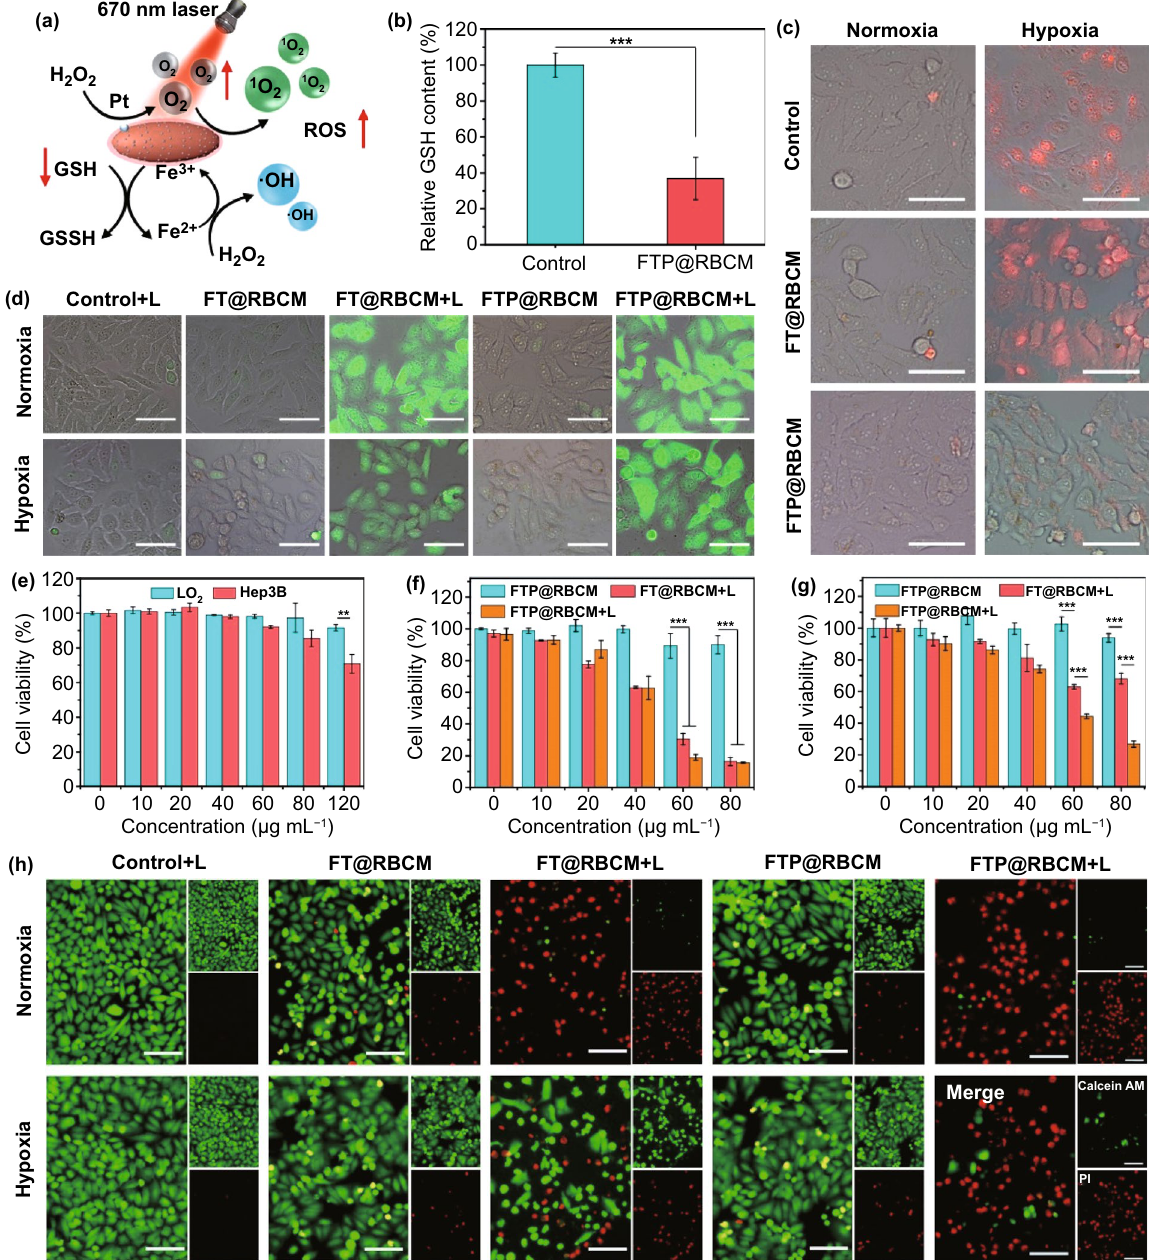
Fig. 3 a Schematic illustration of the multiple catalytic activities of FTP@RBCM. b Relative GSH content of Hep3B cells with various treatments ( n = 3). c Fluorescence microscopy images of probes [Ru(dpp) 3 ]Cl 2 to detect intracellular oxygen with various treatments. Scale bar = 50 µm. d Fluorescence microscopy images of DCFH-DA to detect intracellular ROS with various treatments. Scale bar = 50 µm. e Cell viabilities of LO2 and Hep3B cells after incubation with FTP@RBCM ( n = 4). f, g Cell viabilities of Hep3B cells after different treatments under normoxia ( f ) or hypoxia ( g ) ( n = 4). h Fluorescence microscope images of Hep3B cells stained by Calcein AM and PI. Scale bar = 100 µm